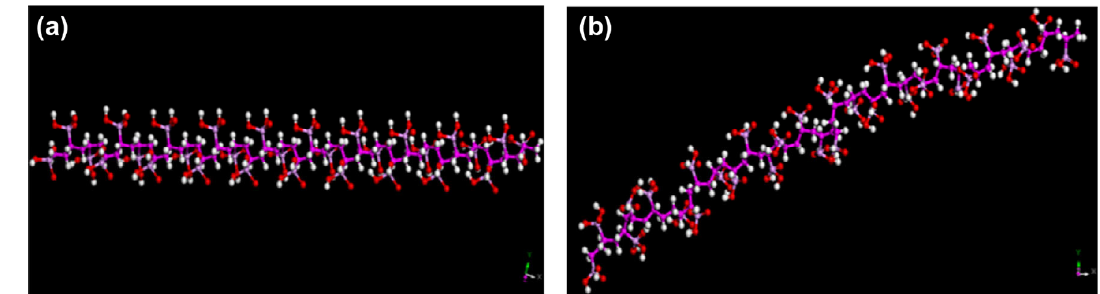
Fig. 3 PVPA molecular chain with 30 repeating units: (a) before optimization; (b) after